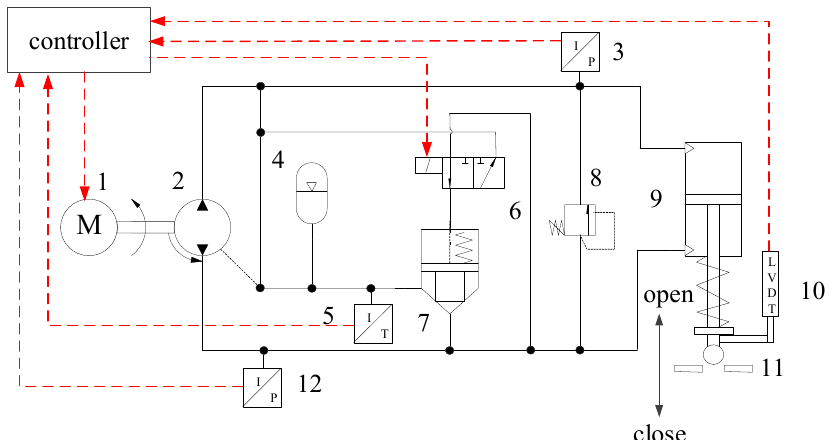
Figure 2. 1: servomotor, 2: quantitative pump, 3: low-pressure sensor, 4: accumulator, 5: temperature sensor, 6: electromagnetic directional valve, 7: two-way cartridge valve, 8: relief valve, 9: hydraulic cylinder, 10: displacement sensor, 11: steam control valve, 12: high-pressure sensor. Working system diagram of PCSM.